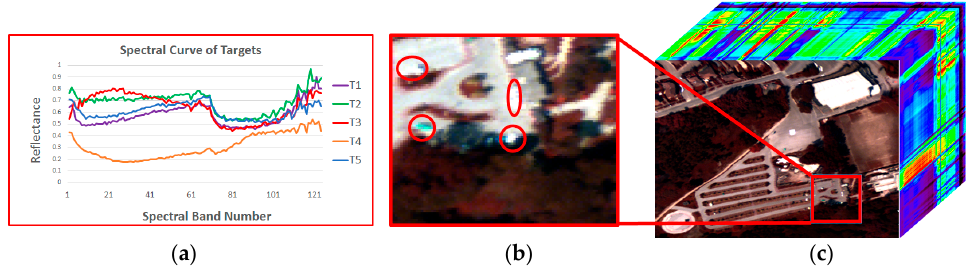
Figure 5. Viareggio real dataset: ( a ) the spectral curve of targets; ( b ) The location of targets in selected subset; and, ( c ) the original data.